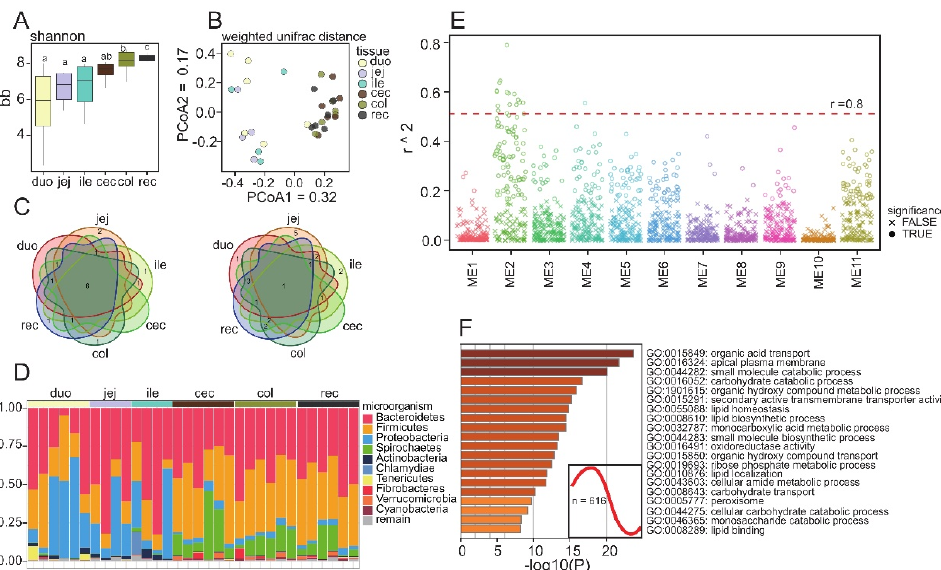
Figure 4. Microorganisms of different intestinal segments ( A ) Alpha diversity analysis based on the faith PD index; ( B ) PcoA analysis based on weighted Unifrac distance; ( C ) Venn diagrams show the distribution of the bacteria in different intestinal segments, and the top 10 most abundant microbes are shown; ( D ) Microbial composition of different intestinal segments at phylum level; ( E ) Manhattan diagram shows the correlation between microorganism and modules, and p < 0.01 is regarded as significant correlation. ( F ) Expression trend and functional enrichment results of modules 2. Duo: